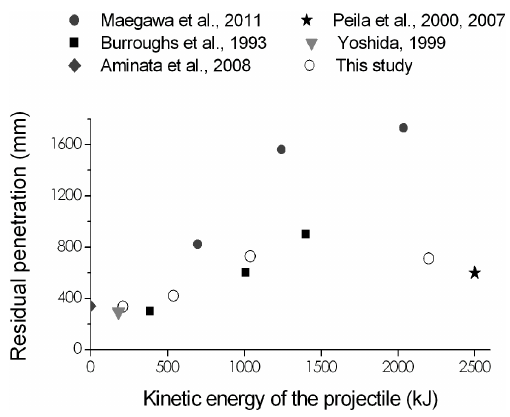
Figure 17. Penetration measured after impact on different real-scale